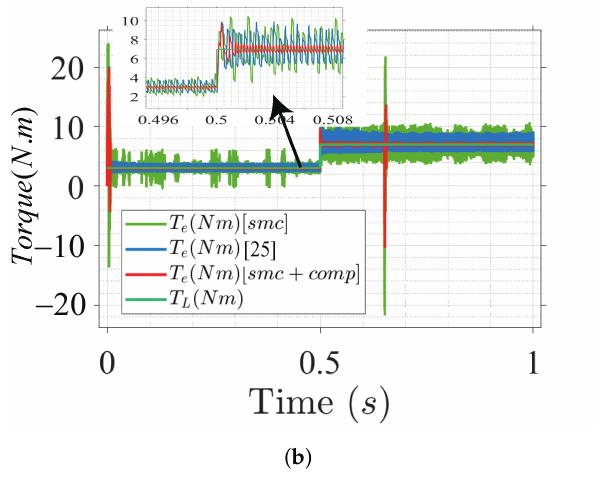
Figure 7. IPMSM current and torque response under nominal parameters with load step variation. ( a ) Motor phase current. ( b ) Torque response. Figure 8 shows the drive phase current along the d and q -axis. Based on conventional methods, the d and q -axis currents show higher current ripples, whereas the proposed control design shows minimum ripples across the d and q -axis current.